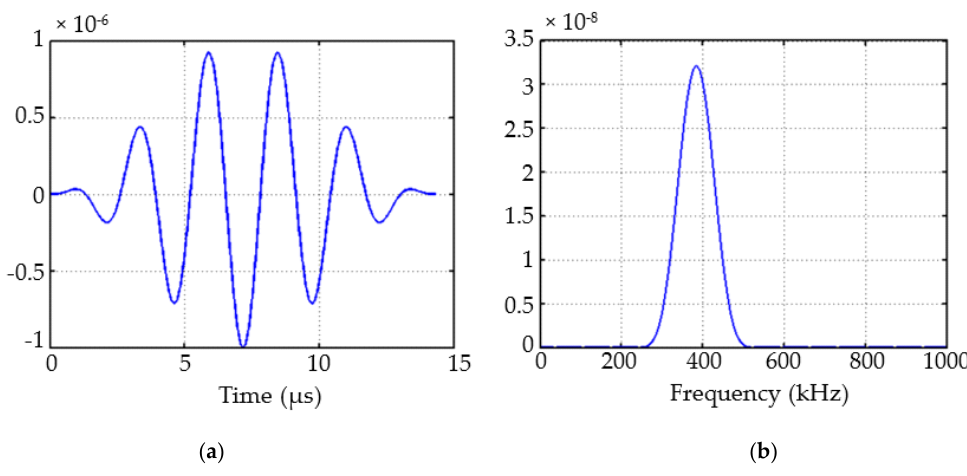
Figure 4. The excitation signal: ( a ) time domain and ( b ) frequency domain.